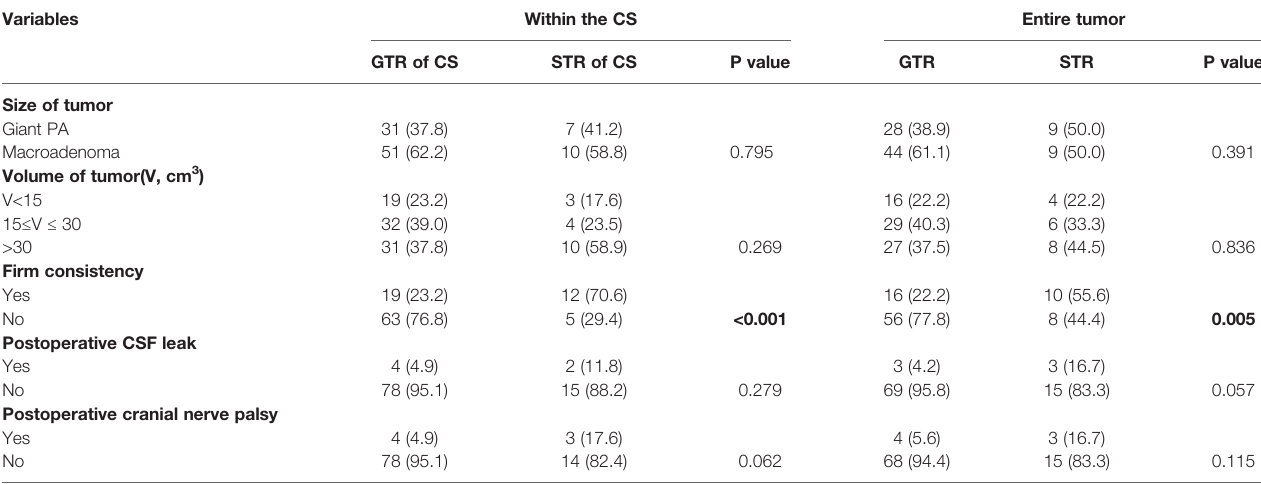
TABLE 4 | Extent of resection correlated with multiple potential variables.